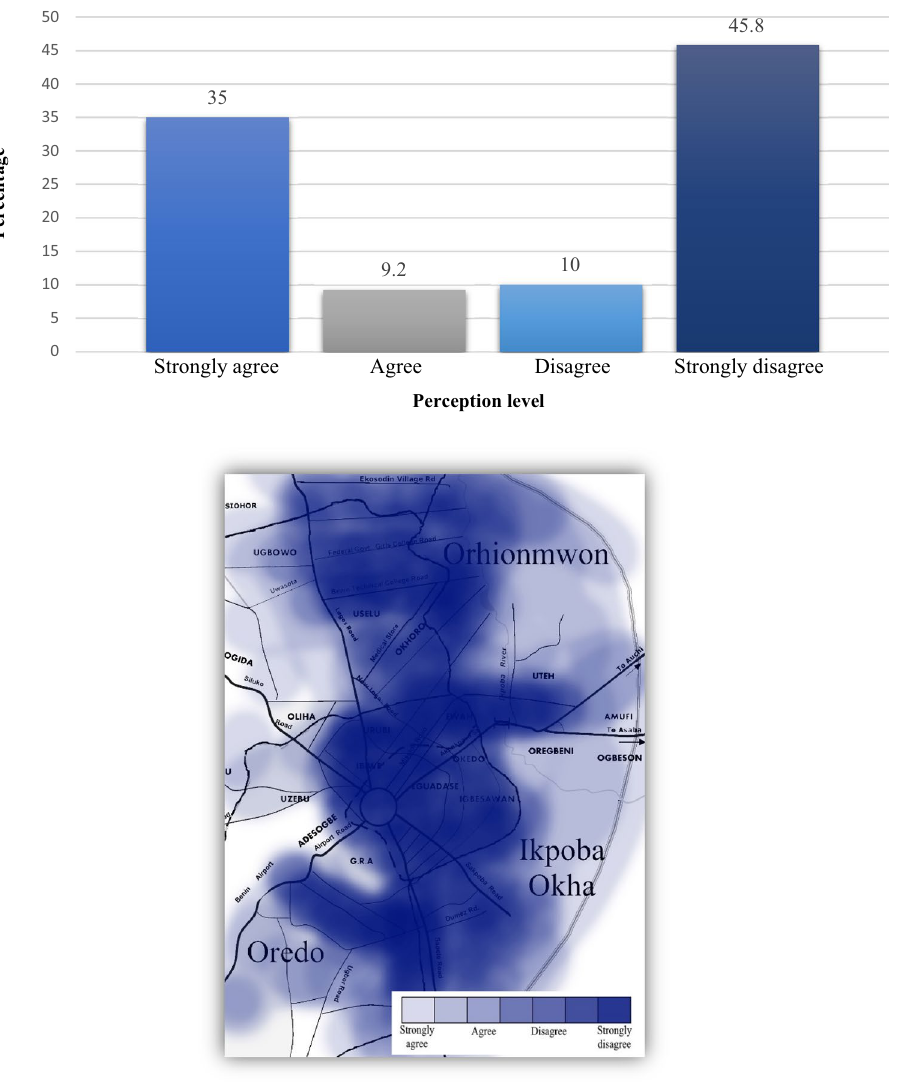
Figure 4. Perception of efficiency level of urban waste control and management in Benin City: (top) graph, (bottom) mapped results.